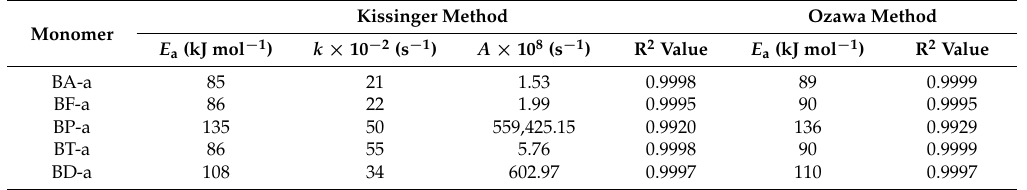
Table 3. Kinetic parameters for the polymerization of bis -benzoxazine monomers.